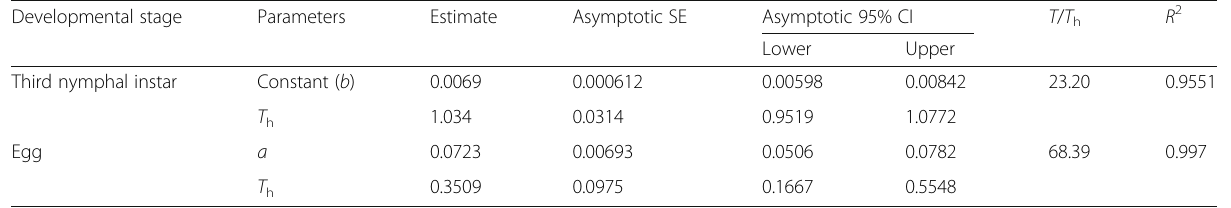
Table 2 Estimated (mean ± SE) searching efficiency ( a ) and handling time ( T h ) of O. albidipennis female on eggs and third nymphal stages of B.